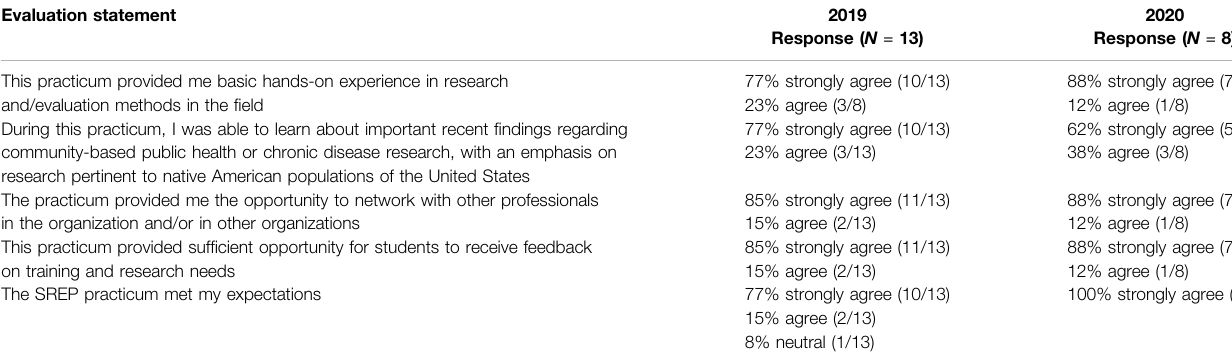
TABLE 5 | Evaluation results for 2020 Summer Research Enhancement Program practicum